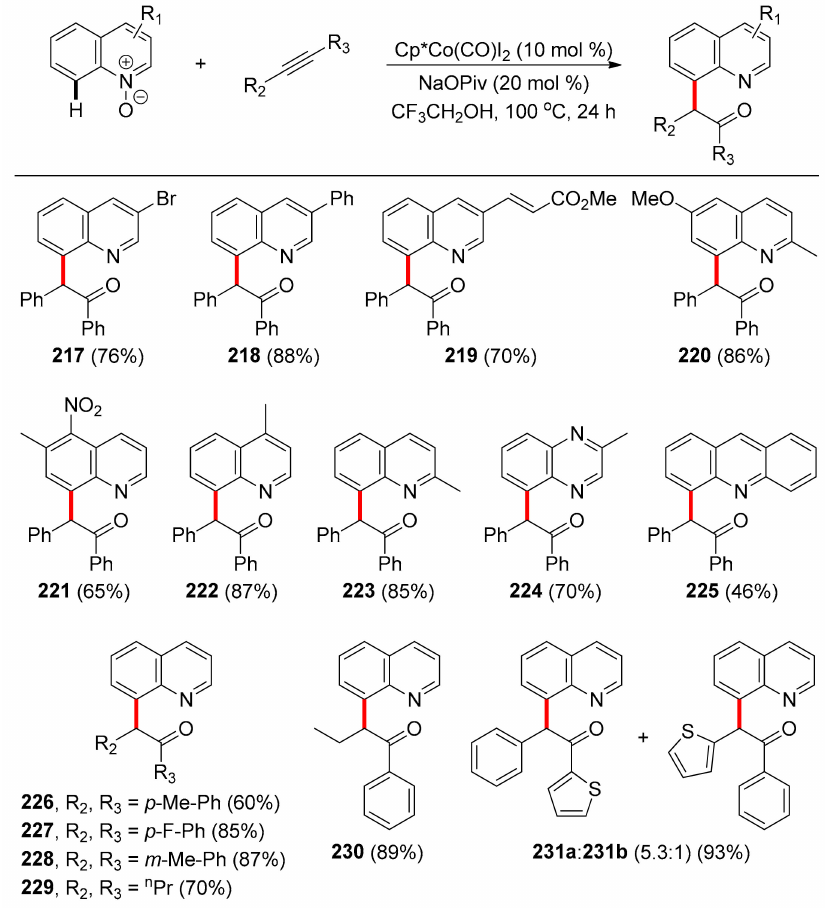
Scheme 16. Co-catalyzed, C(8)-H bond functionalization of quinoline with internal alkynes, using quinoline- N -oxide as a